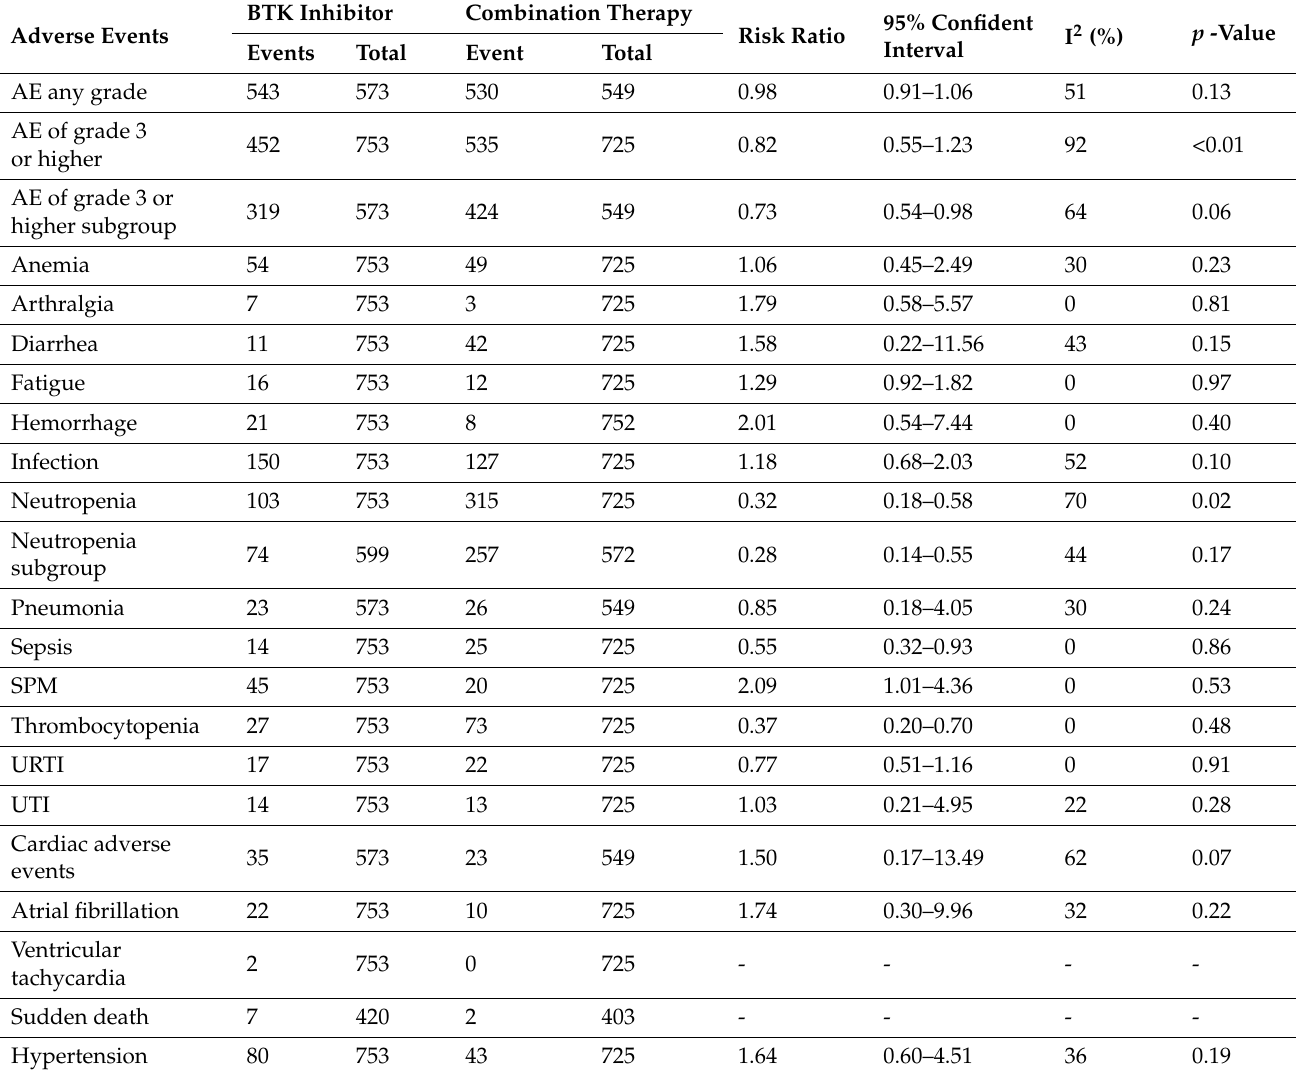
Table 4. Summary of pooled relative risk for grade 3 or higher adverse